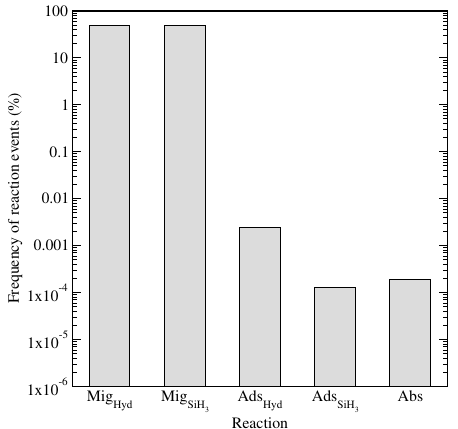
Figure 10. Normalized frequency of reaction events within the present kMC scheme at T = 475 K, P = 1 Torr, and a SiH in mole fraction of 4